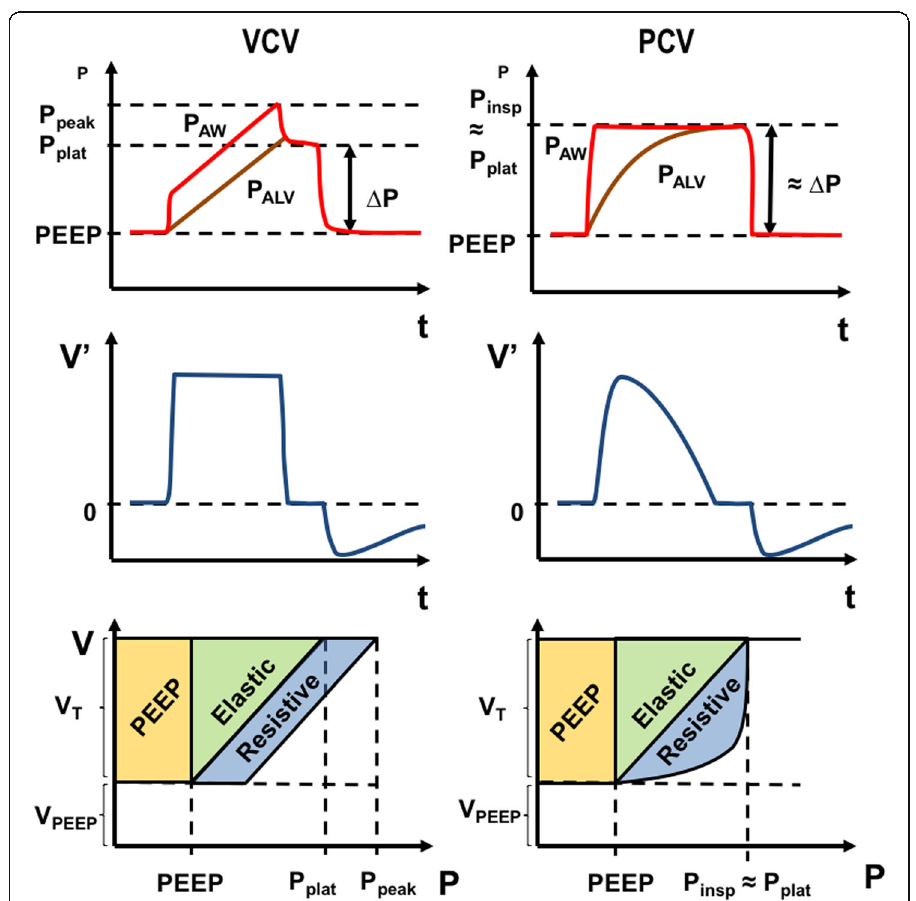
Fig. 5 Mechanical power during volume- and pressure-controlled ventilation. Top panels represent the typical pressure-time curve of these two controlled ventilation modes; middle panels, the flow-time curves; and bottom panels, the weight of different power components in the two ventilation modes. VCV, volume- controlled ventilation; PCV, pressure-controlled